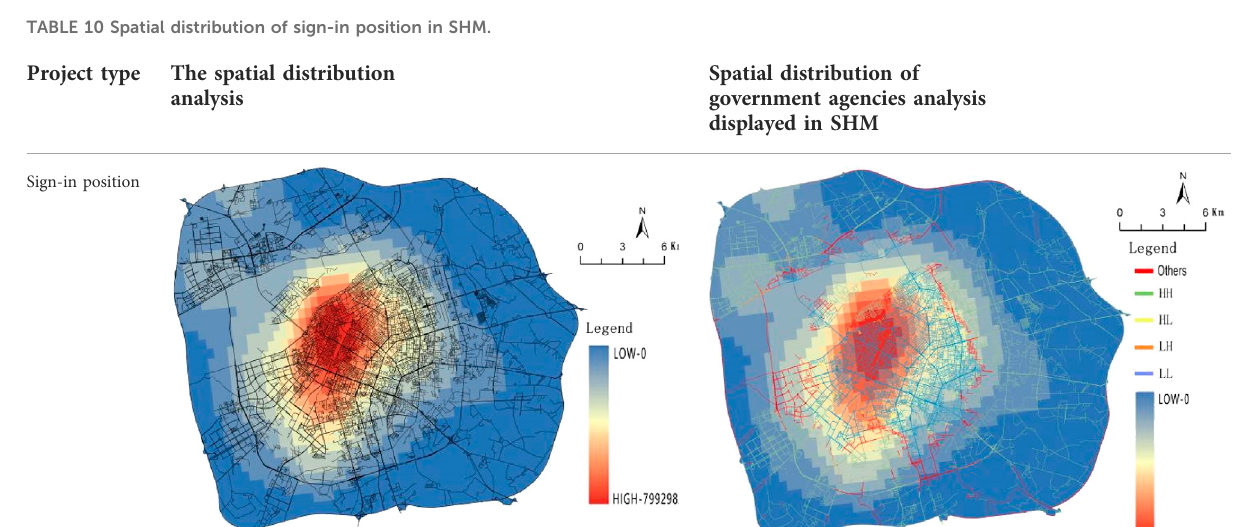
TABLE 10 Spatial distribution of sign-in position in